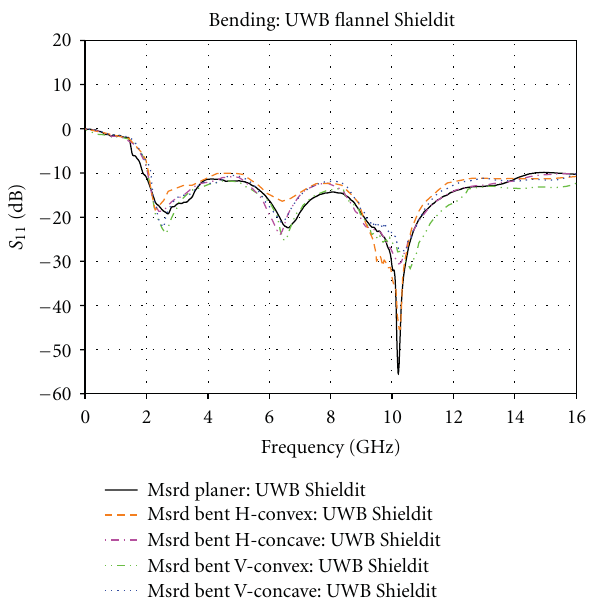
Figure 11: Measured ( | S 11 | ) bending results of UWB antenna prototype using Shieldit conducting